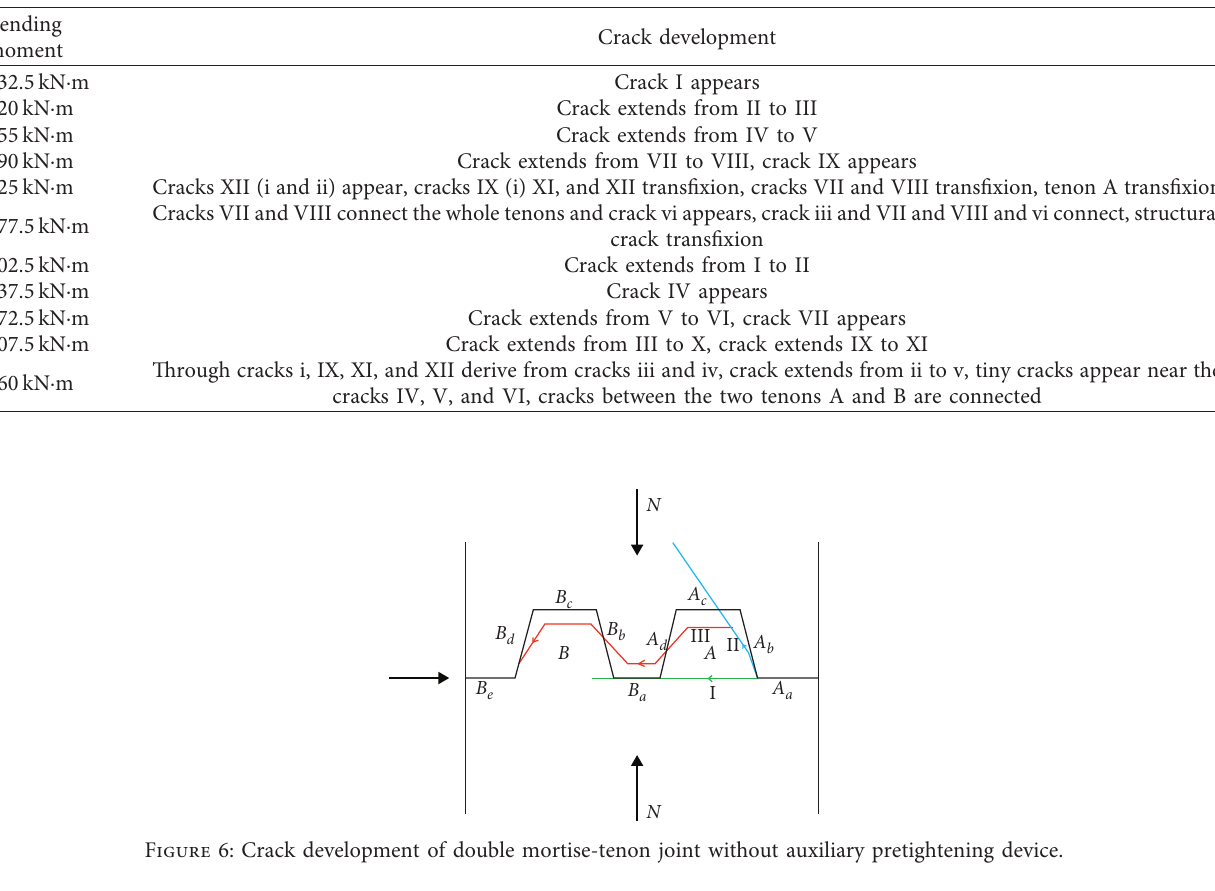
Table 2: Crack development under increasing bending moment.